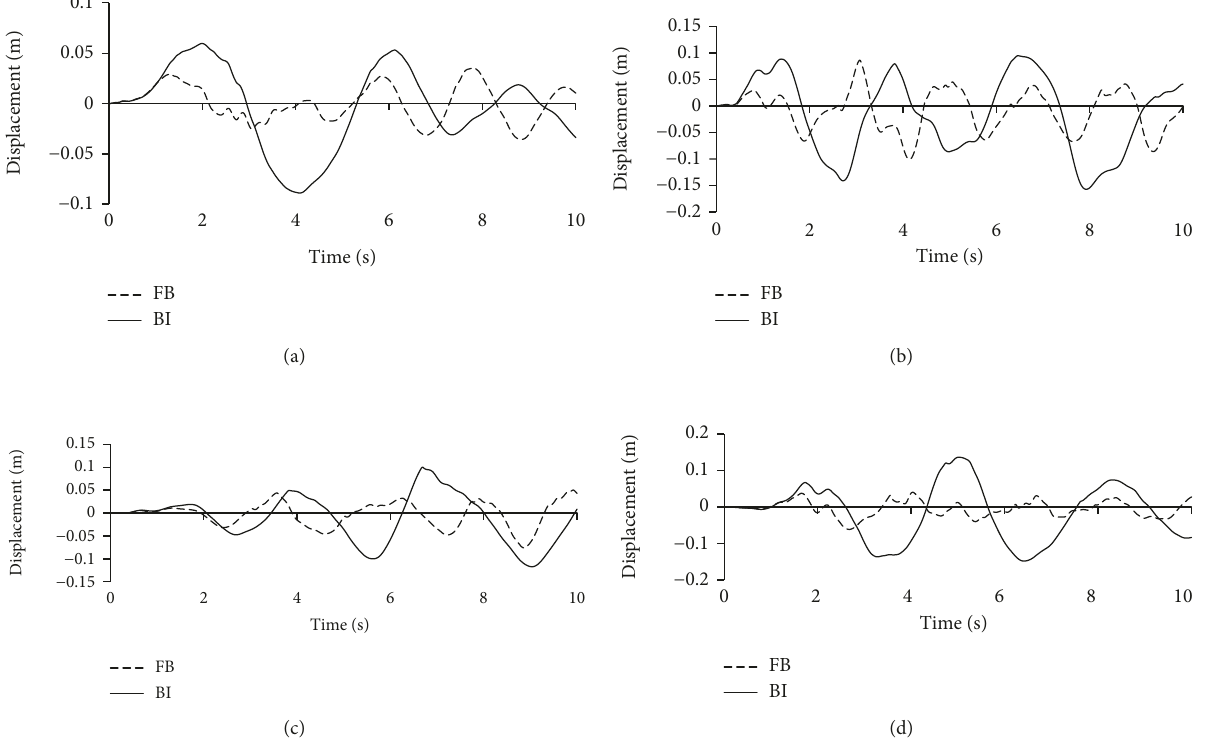
Figure 9: Displacement time history response of the taller building at the pounding level under the motions. (a) Cape. (b) LACC-N. (c) S-Monica. (d) El-Centro.